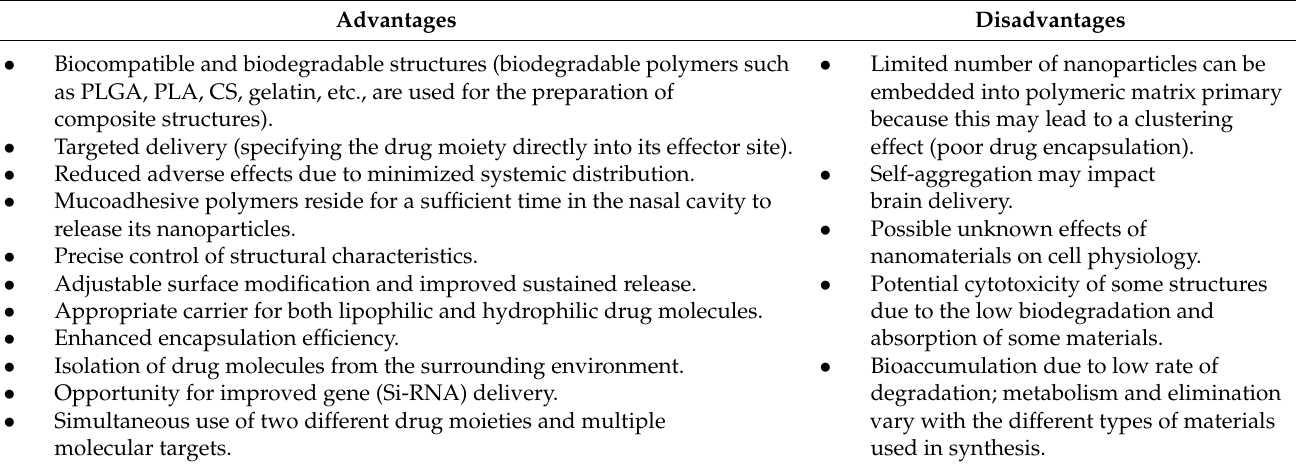
Table 3. Advantages and disadvantages related to polymeric